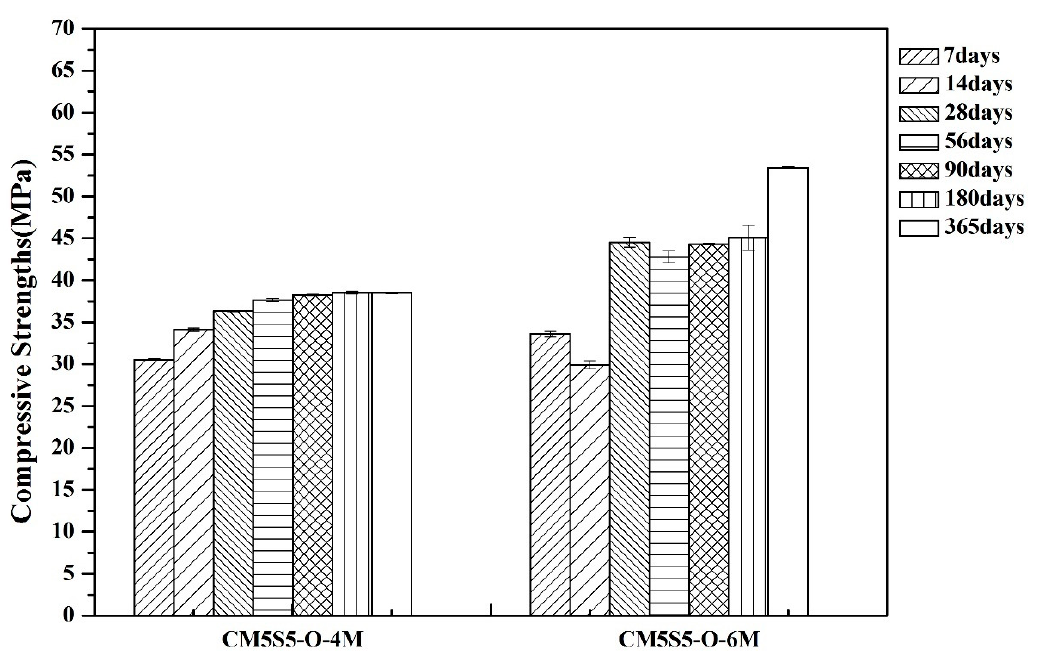
Table 4. Effect of the NaOH molar concentration on the fresh properties of marble-based geopolymer concrete.